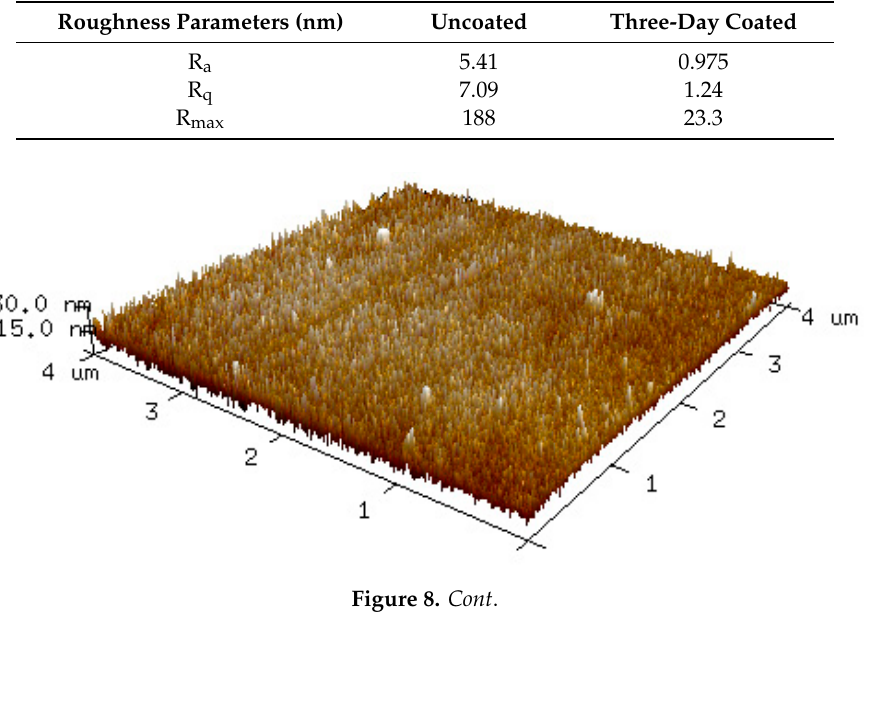
Table 1. The surface roughness parameters of the membranes. Roughness Parameters (nm)